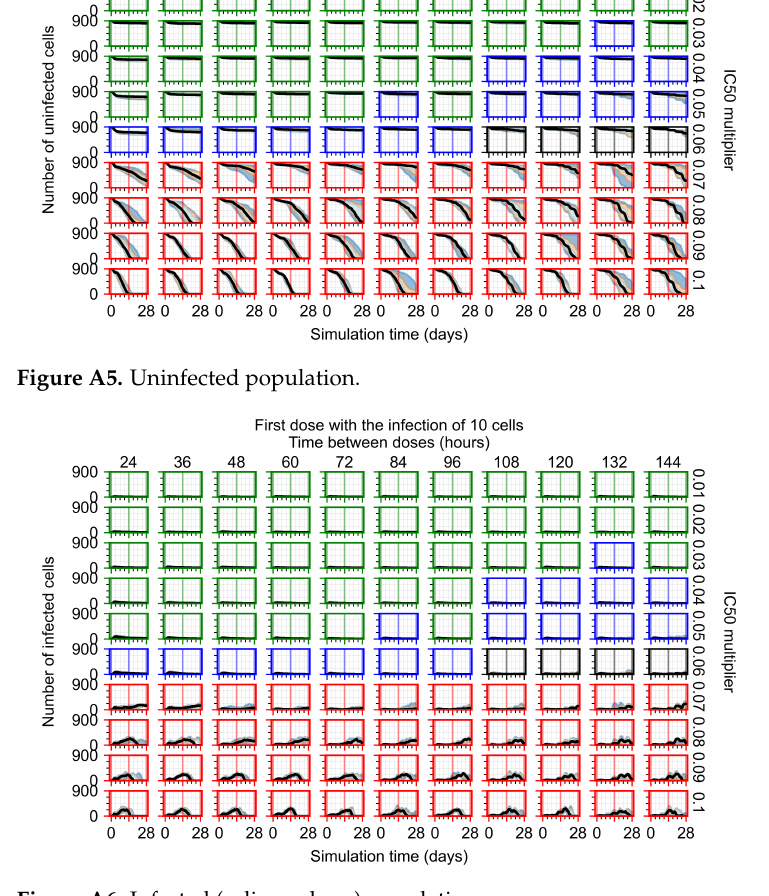
Figure A6. Infected (eclipse phase) population.